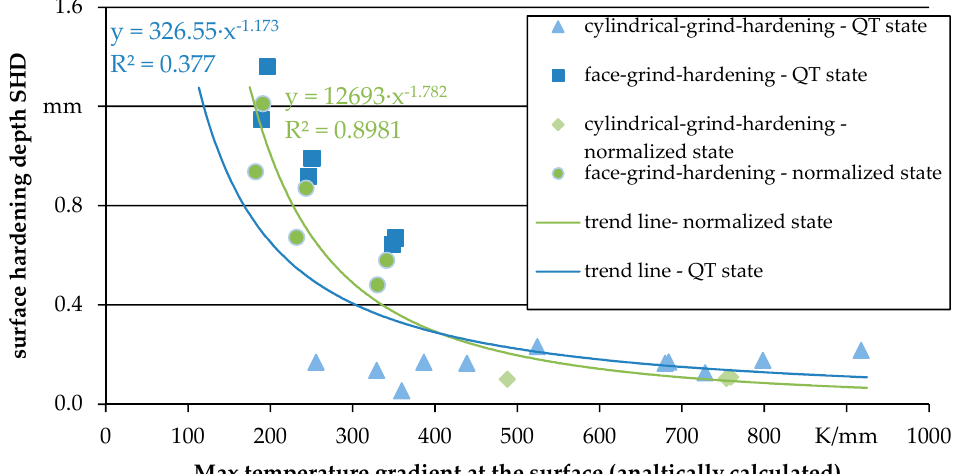
Figure 6. The surface hardening depth (SHD) due to the maximum temperature gradient at the surface (dT/dx) max .